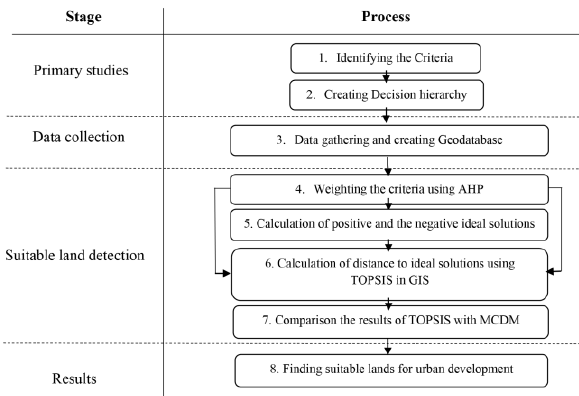
Figure 1. The proposed framework of the research